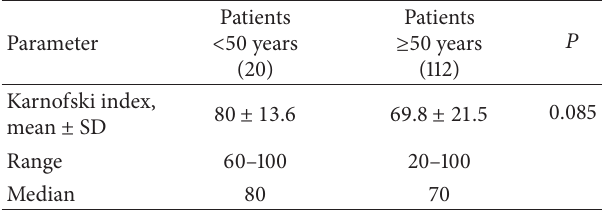
Table 7: Performance status assessed by Karnofski scale (6 months after the